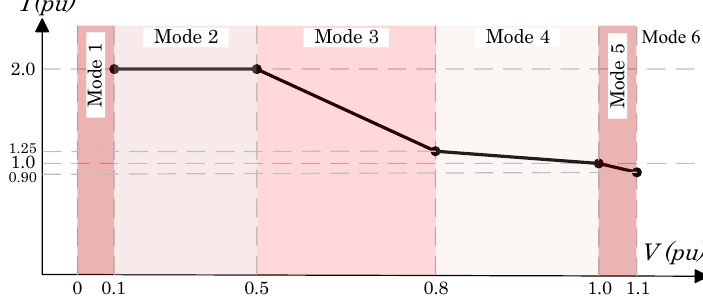
Figure 2. IBDG V × I curve under normal and abnormal voltage conditions.